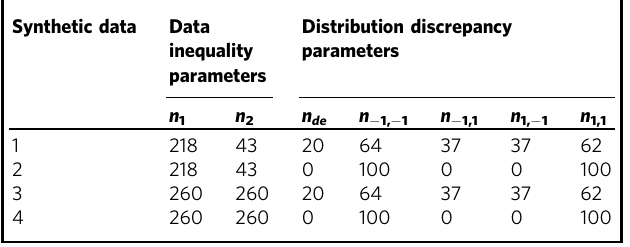
Table 3 Parameters used to generate the synthetic